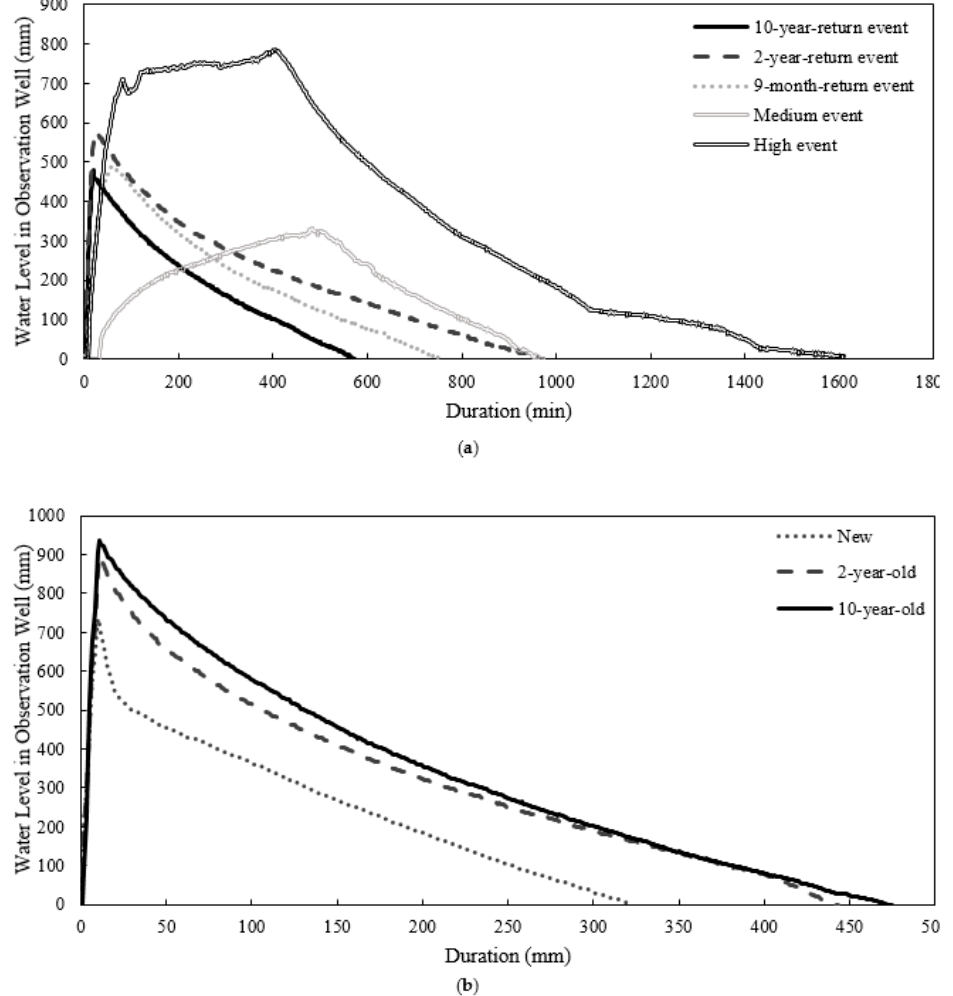
Figure 8. Water level in the observation well for ( a ) bioswale; ( b ) infiltration trench. ( a ) Water level